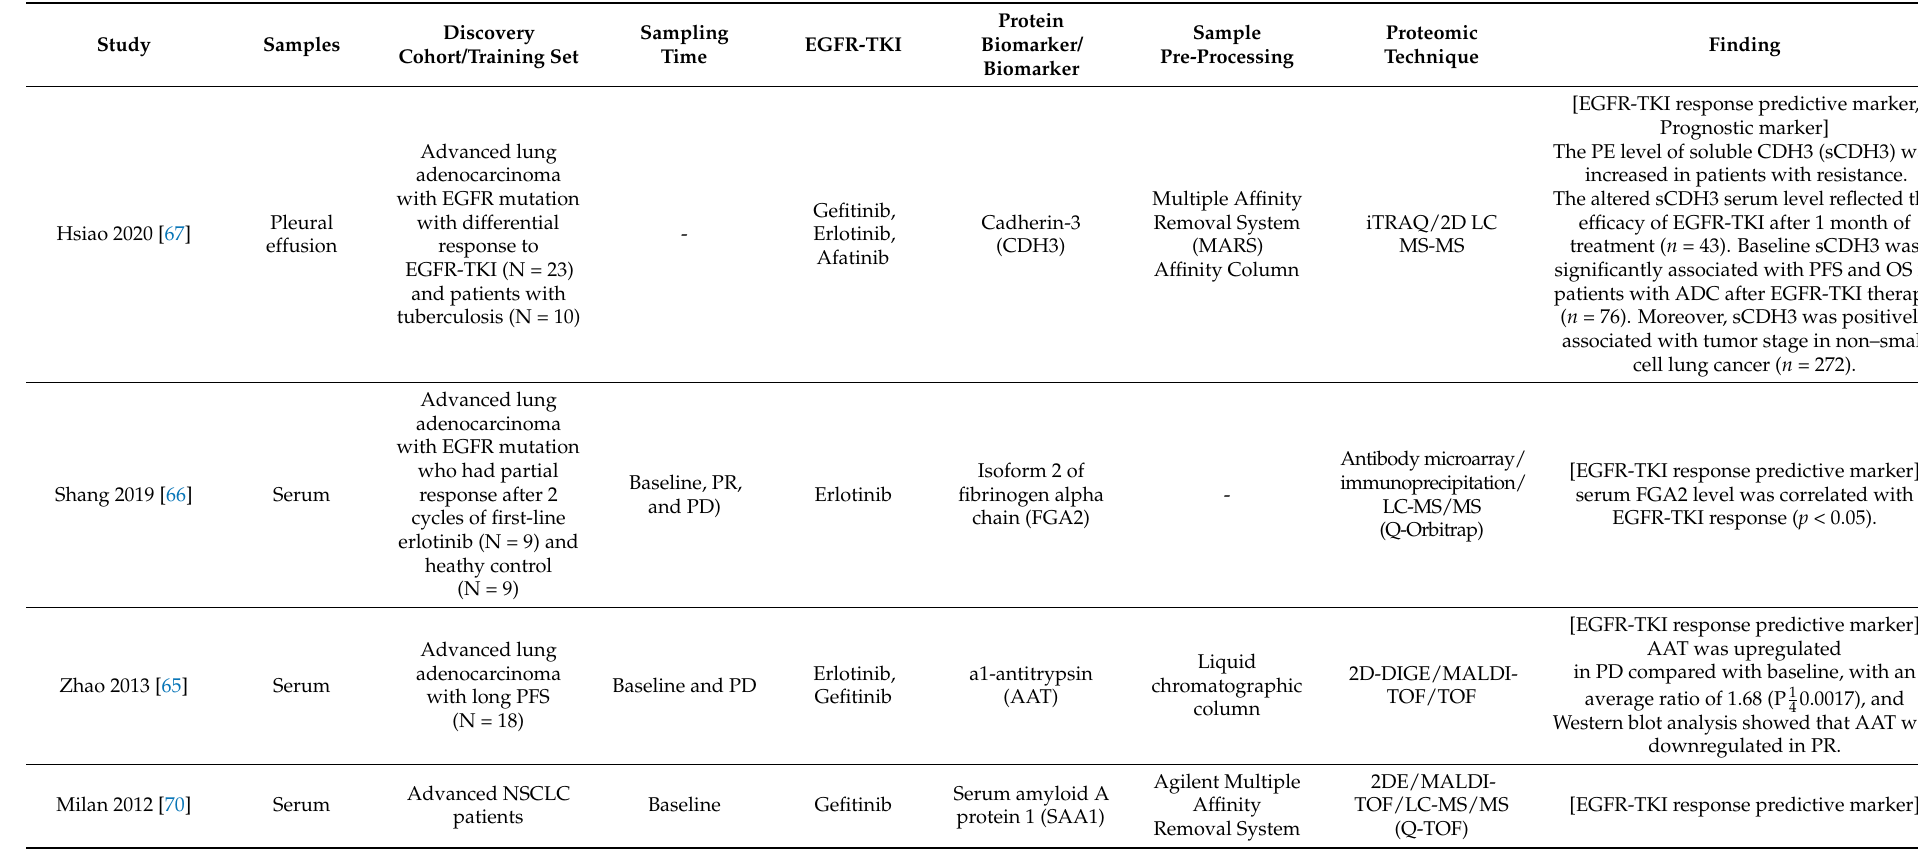
Table 3. Summary of proteomic studies in EGFR-TKI resistance in biofluid specimens of